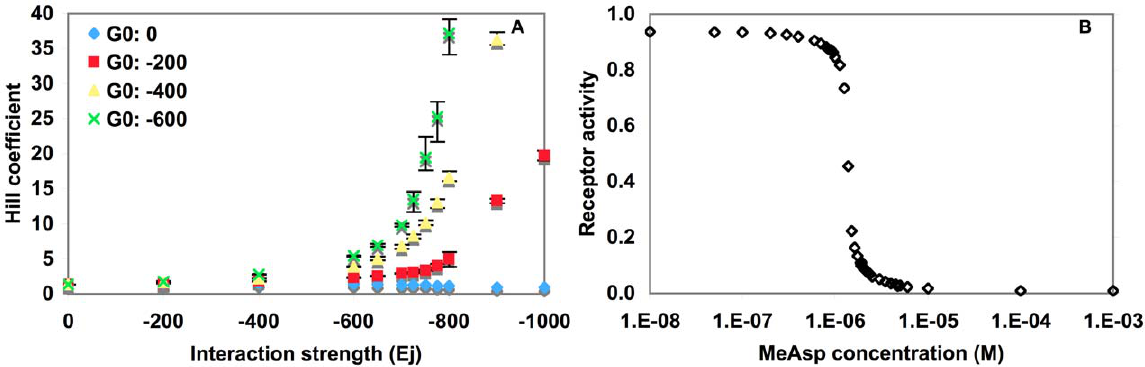
Figure 3. Simulations of a homogeneous receptor population of 1083 Tar receptor dimers. Data points are the mean values from three independent simulations. ( A ) Hill coefficient as a function of interaction strength for four different G 0 values (blue diamond: G 0 =0, red square: G 0 = 2 200, yellow triangle: G 0 = 2 400, green x: G 0 = 2 600). Error bars indicate minimum and maximum Hill coefficients from three independent runs. ( B ) Average Tar receptor activity in a homogenous array, as a function of MeAsp concentration, for an interaction strength of 2 700 cal mol 2 1 and G 0 of 2 600. Fitting the data to the Hill equation resulted in a Hill coefficient of 9.8.